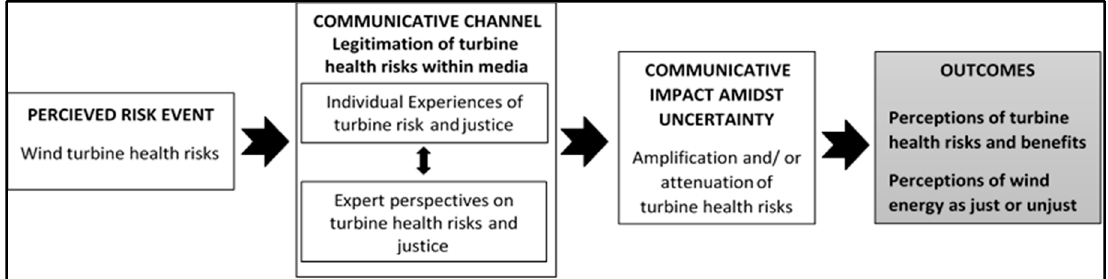
Figure 1. Social Amplification of Risk Framework in the context of wind energy development. Adopted and simplified from Kasperson et al. [30].